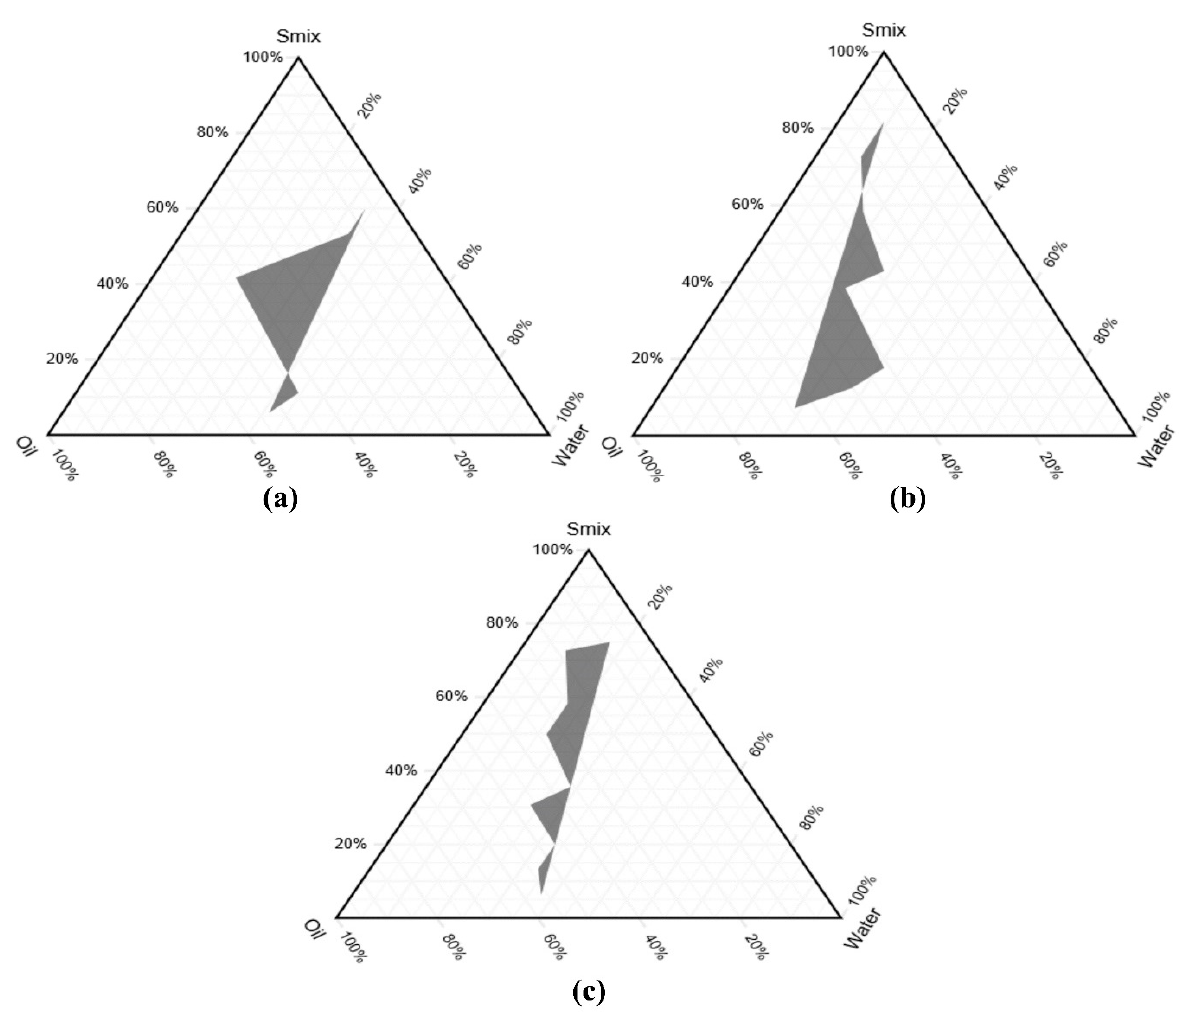
Figure 4 . Pseudo-ternary phase diagram of: ( a ) S mix ratio 1:1; ( b ) S mix ratio 2:1; ( c ) S mix ratio 3:1. Figure 4. Pseudo-ternary phase diagram of: ( a ) S